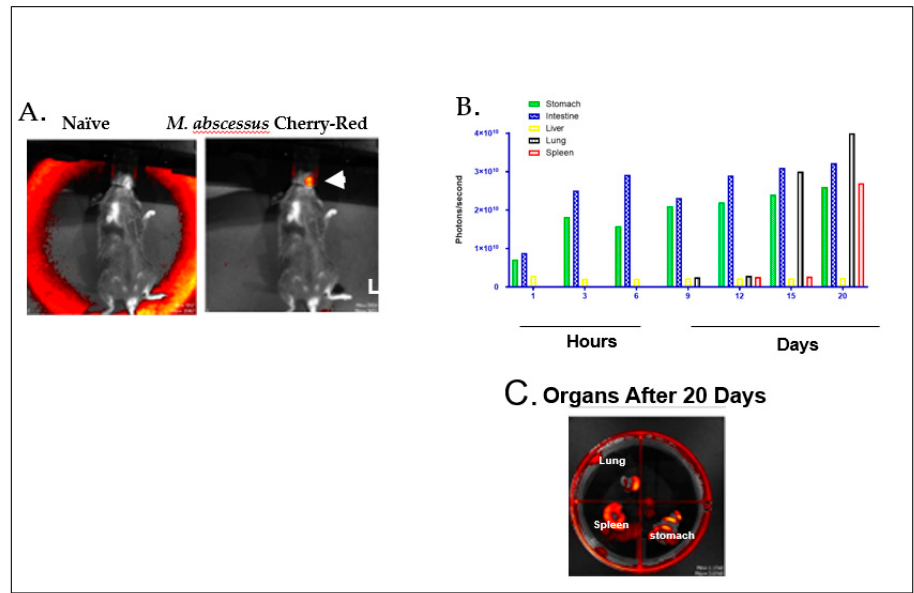
Figure 1. ( A ) C57BL6 mice infection by gavage with Mycobacterium abscessus OM194 strain expressing fluorescent marker in cherry-red. Infection in naïve shows no infection (red, white arrow). ( B ) Dissemination of M. abscessus OM194 strain mainly in the lung and spleen after 20 days of oral gavage infection. ( C ) Organs excised from the mouse after 20 days can individually receive xenogeny imaging for quantification of the bacterial burden expressions photon/second.